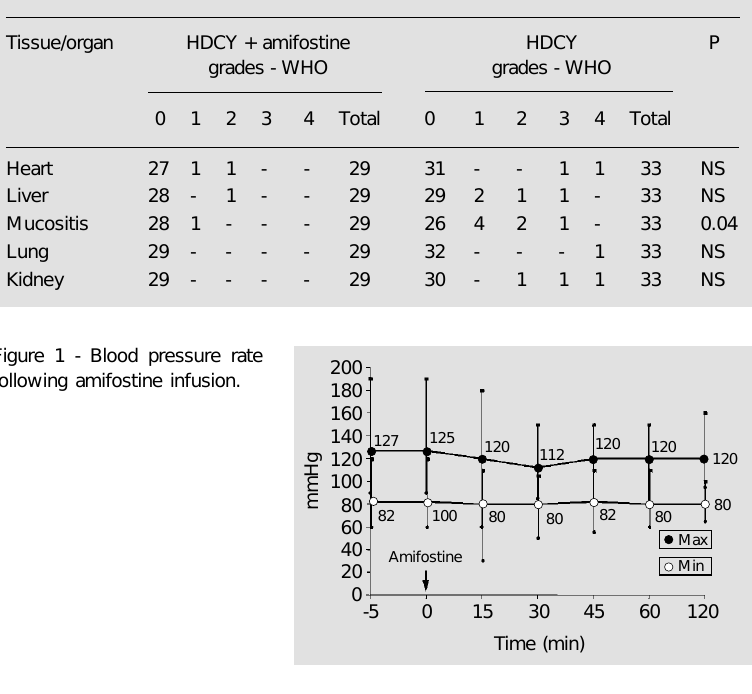
infusion.Table 3 - Toxicity related to HDCY therapy in patients protected or not with amifostine (WHO